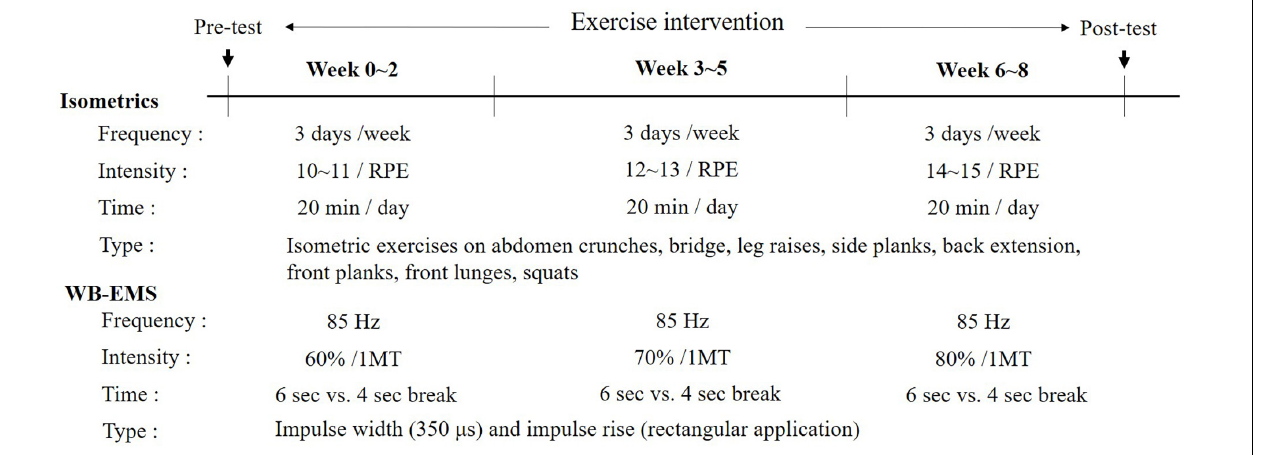
FIGURE 2 | Flow chart regarding timing of outcome assessment and